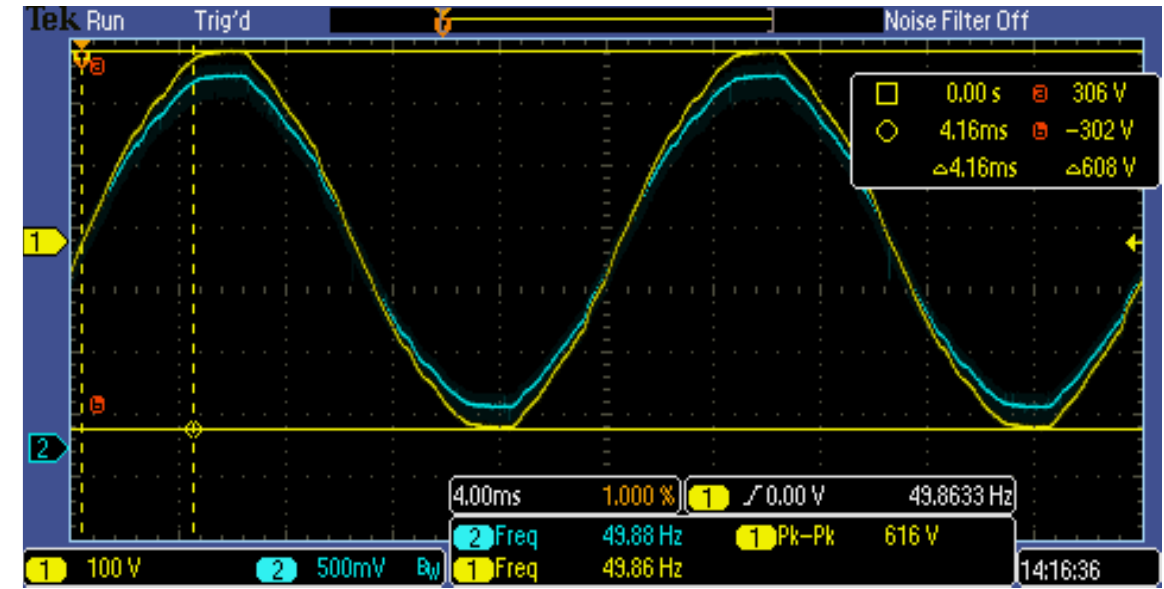
Figure 26. Oscilloscope capture of line input signal waveforms.